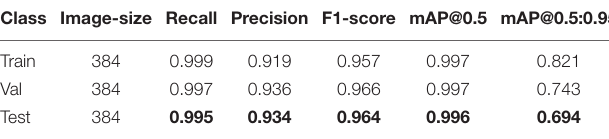
TABLE 4 | Detection model results of SP stage of lettuce based on